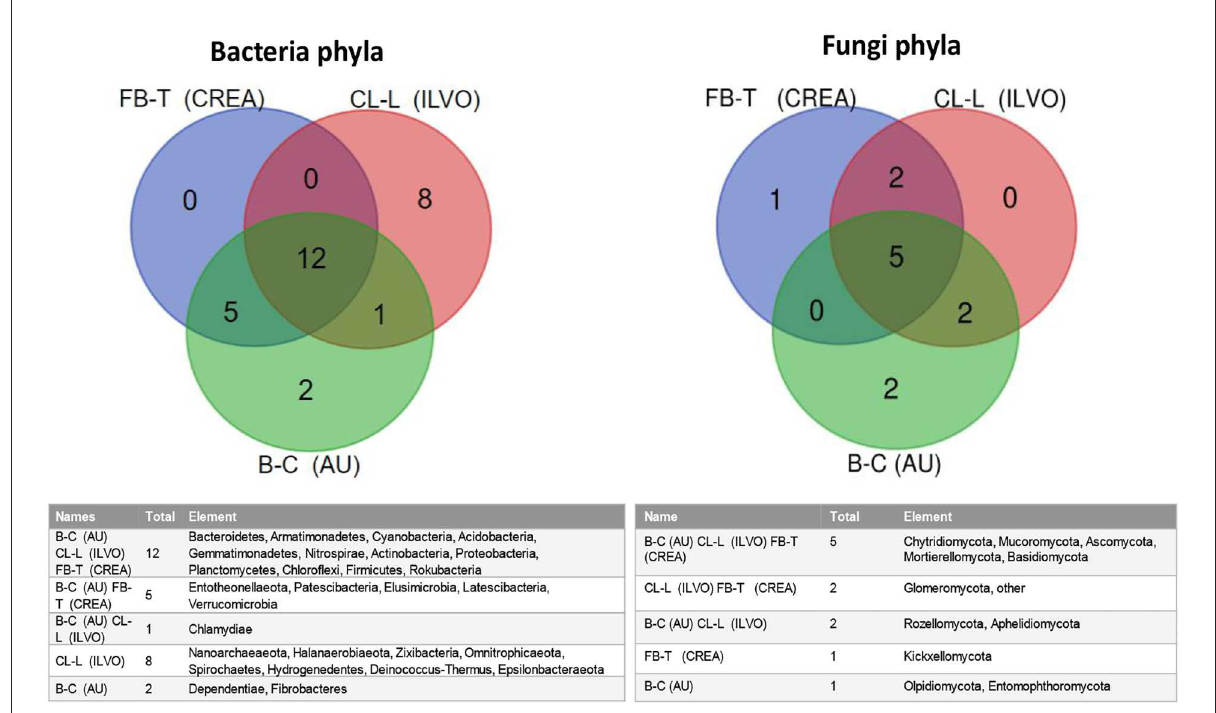
FIGURE7 Venn diagrams of bacteria and fungi phyla in CREA, ILVO, and AU experimental field experiments. IN AU system, data are referred only to beetroot and cabbage MC